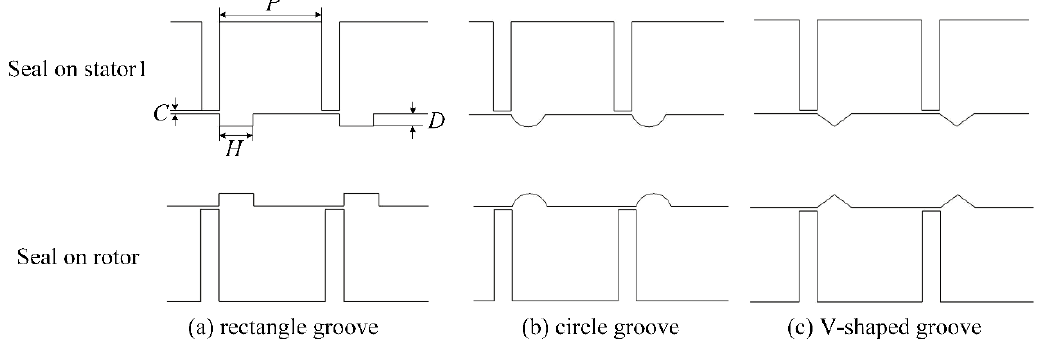
Figure 10. Profiles of seals under di ff erent cavity surface shape.